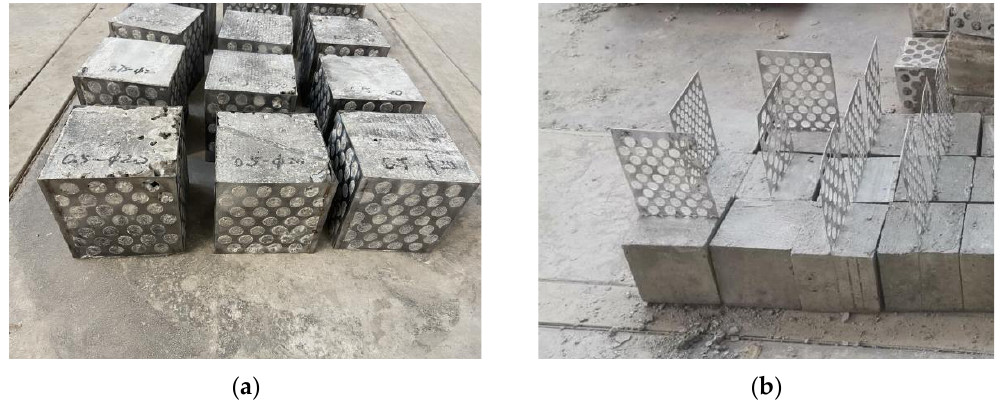
Figure 3. Specimens: ( a ) compression specimens; ( b ) pull-out specimens.